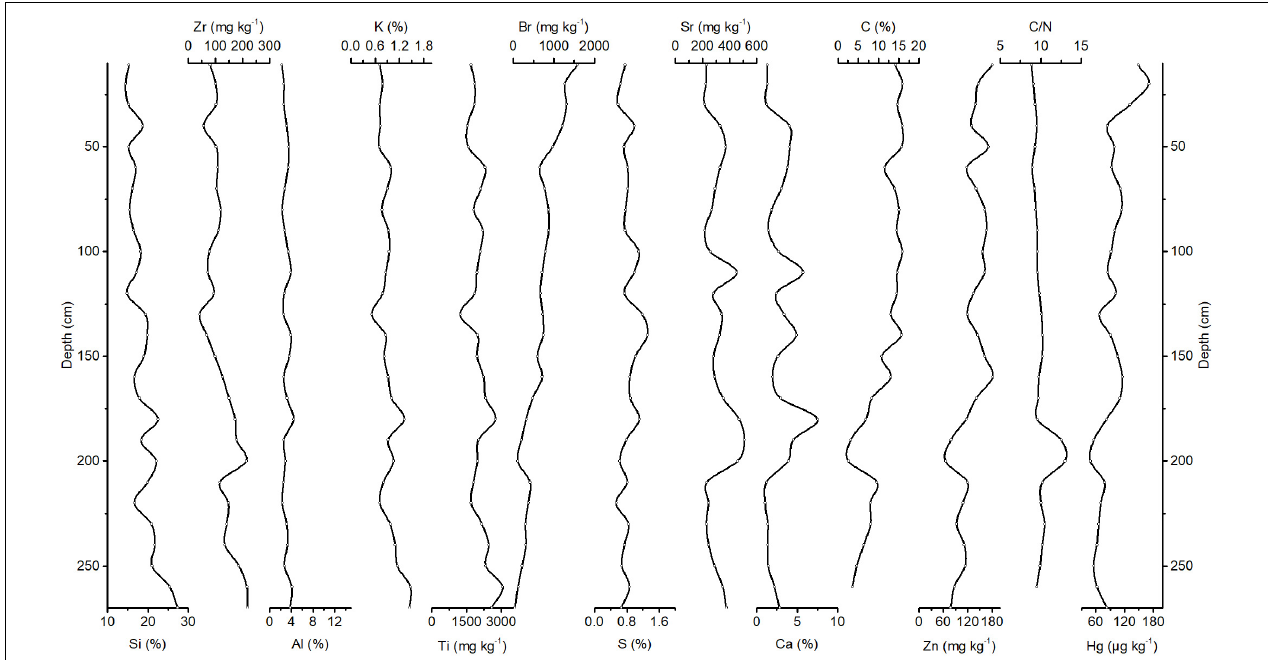
FIGURE 3 | Downcore records of Si, Zr, Al, K, Ti, Br, S, Sr, Ca, C, Zn, and Hg concentrations and C/N ratios of Peru Margin sediments.